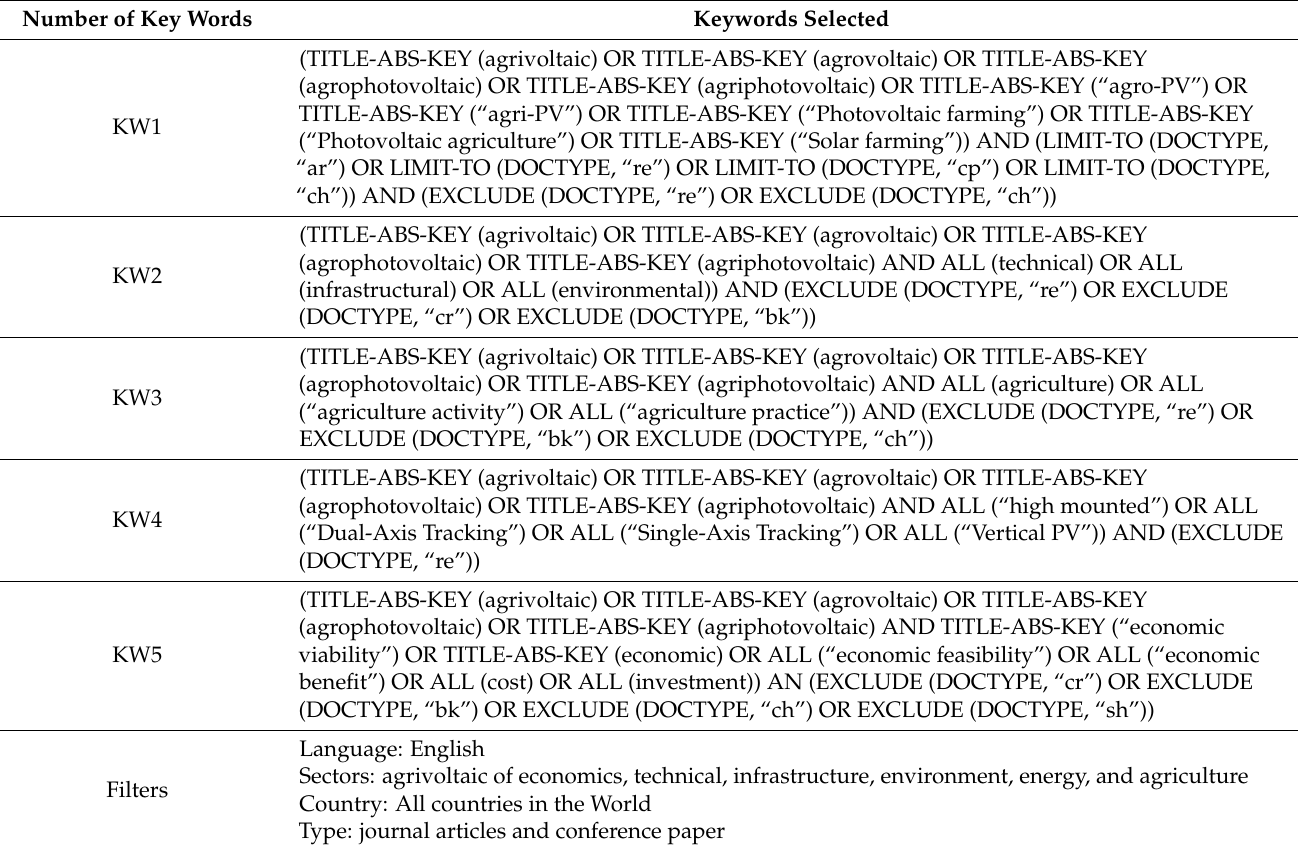
Table A1. Selection Parameters used for peer-reviewed